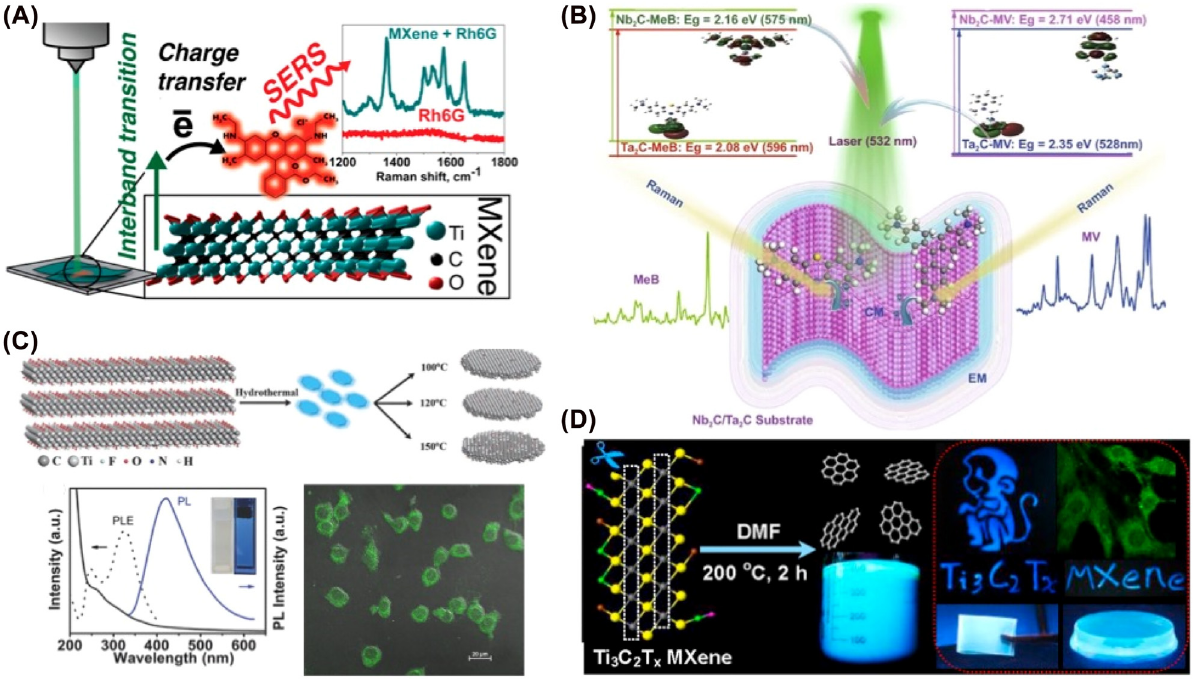
C T has enhanced the Raman signal. (B) Nb 3 2 x